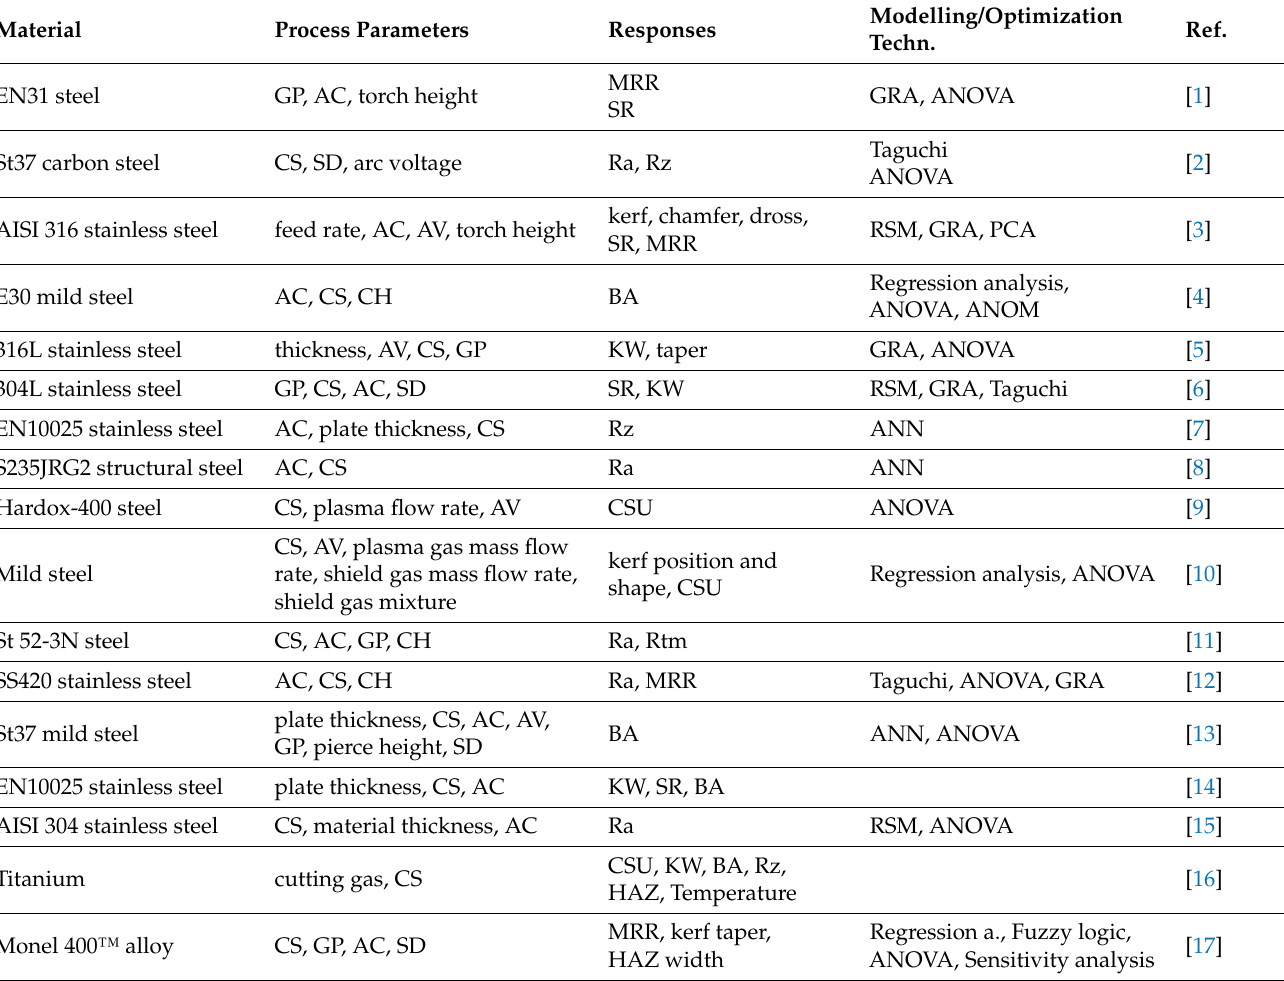
Table 1. Summarized literature